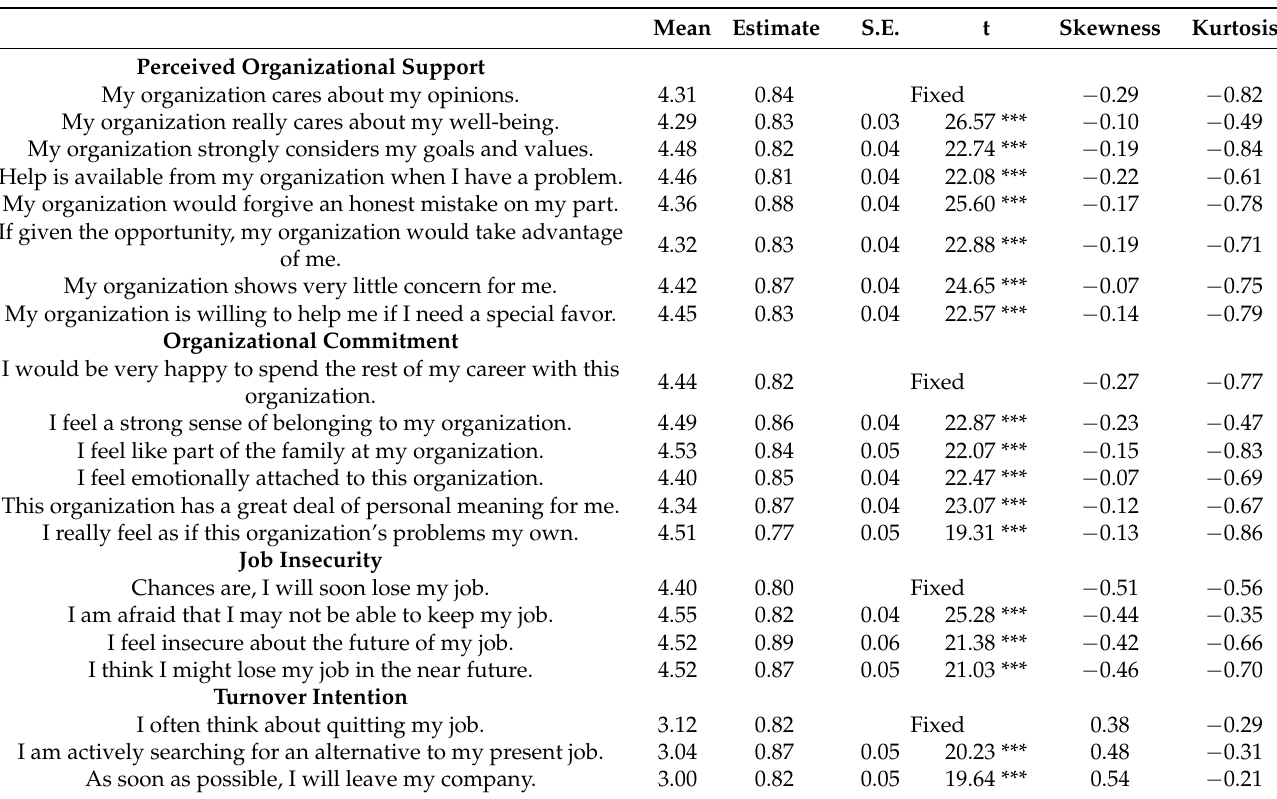
Table 2. Measurement model evaluation.